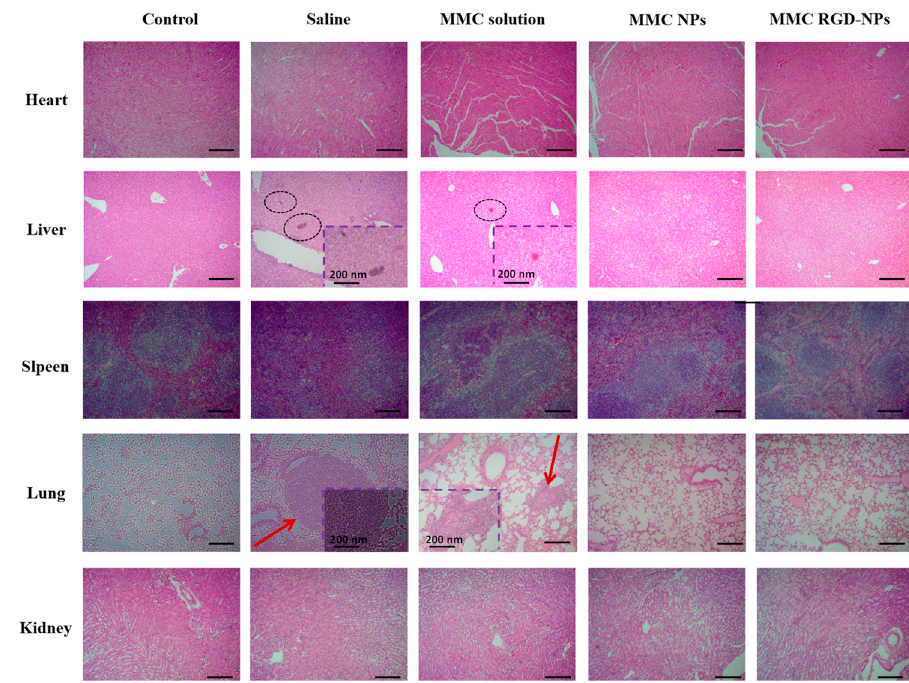
Figure 14. The heart, liver, spleen, lung, and kidney of normal and tumor-bearing mice, treated with saline, MMC solution, MMC NPs, and MMC RGD-NPs, were stained with H&E and observed by optical microscope, 100×. Scale bar = 50 µm. Normal heart, liver, spleen, lung, and kidney were taken as a comparison; circled areas and red arrows show the metastatic areas and the square area was the image of the metastatic areas with large scale.